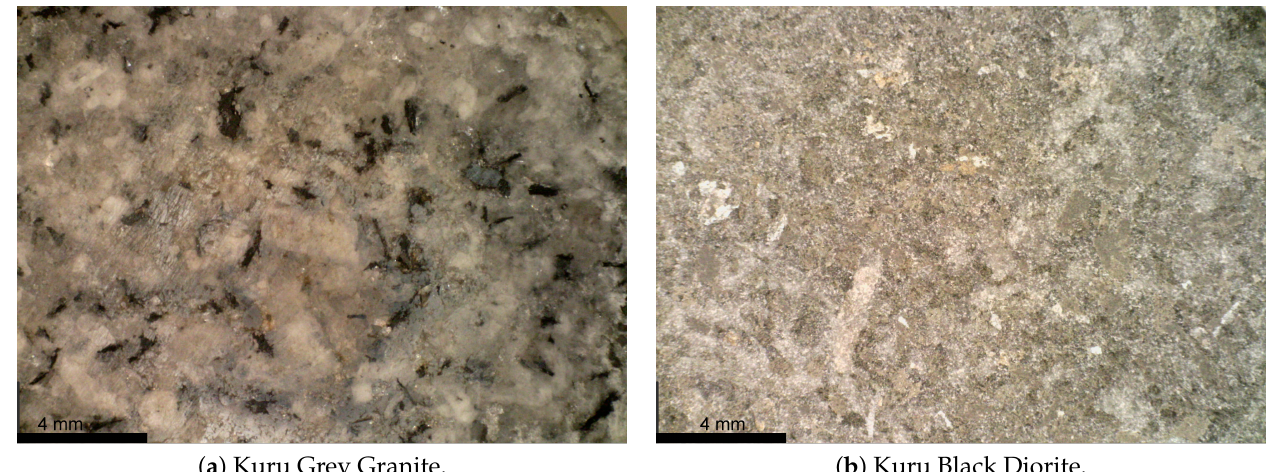
Figure 1. The grain textures of the rocks characterised in this